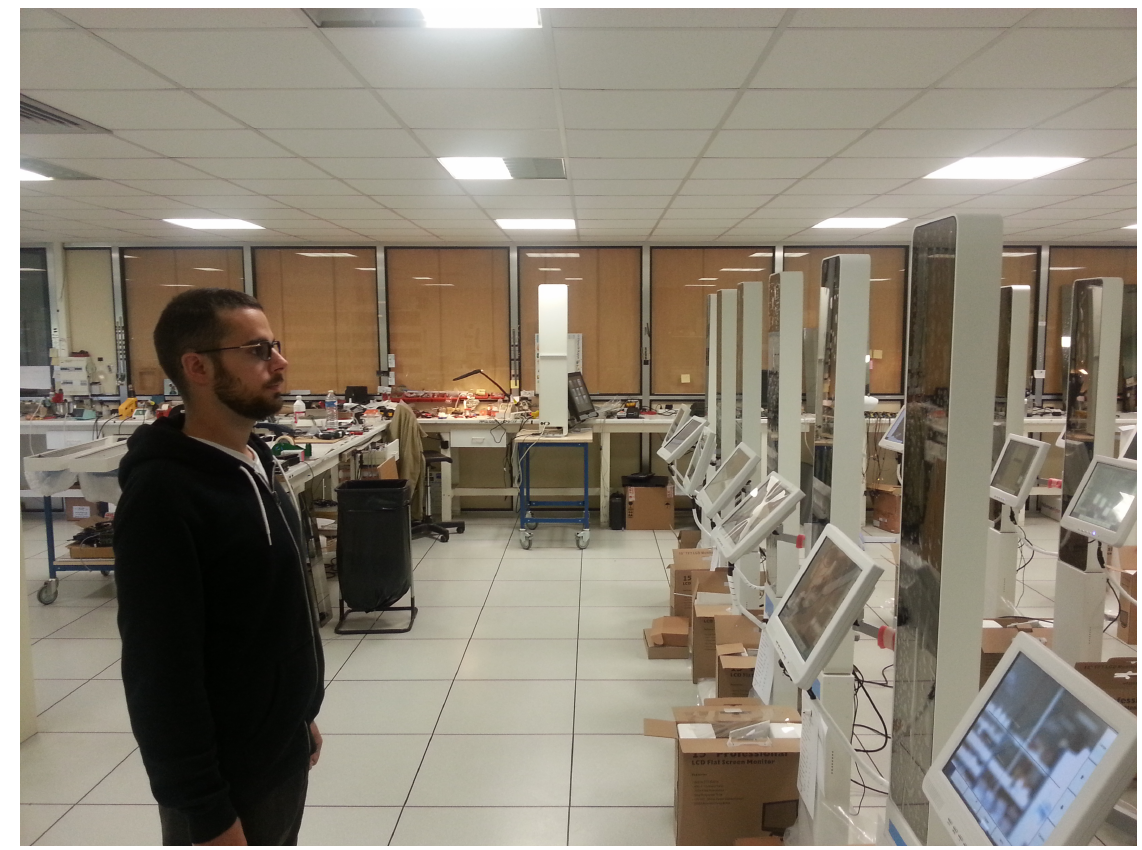
Figure 10. Experimental setup: the patient stands still in front of the device with his head in a vertical